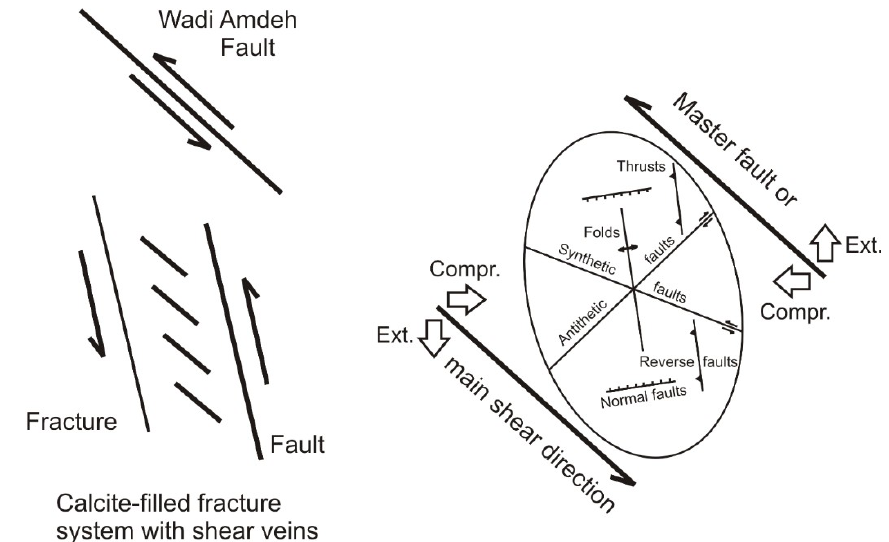
Figure 16. Geometric relationship between the Wadi Amdeh Fault (master fault) and the calcite-filled fracture system. Note that this system cannot be a synthetic element of a sinistral master fault if compared with a respective strain ellipse model (ellipse drawn after [ 61 ] ).